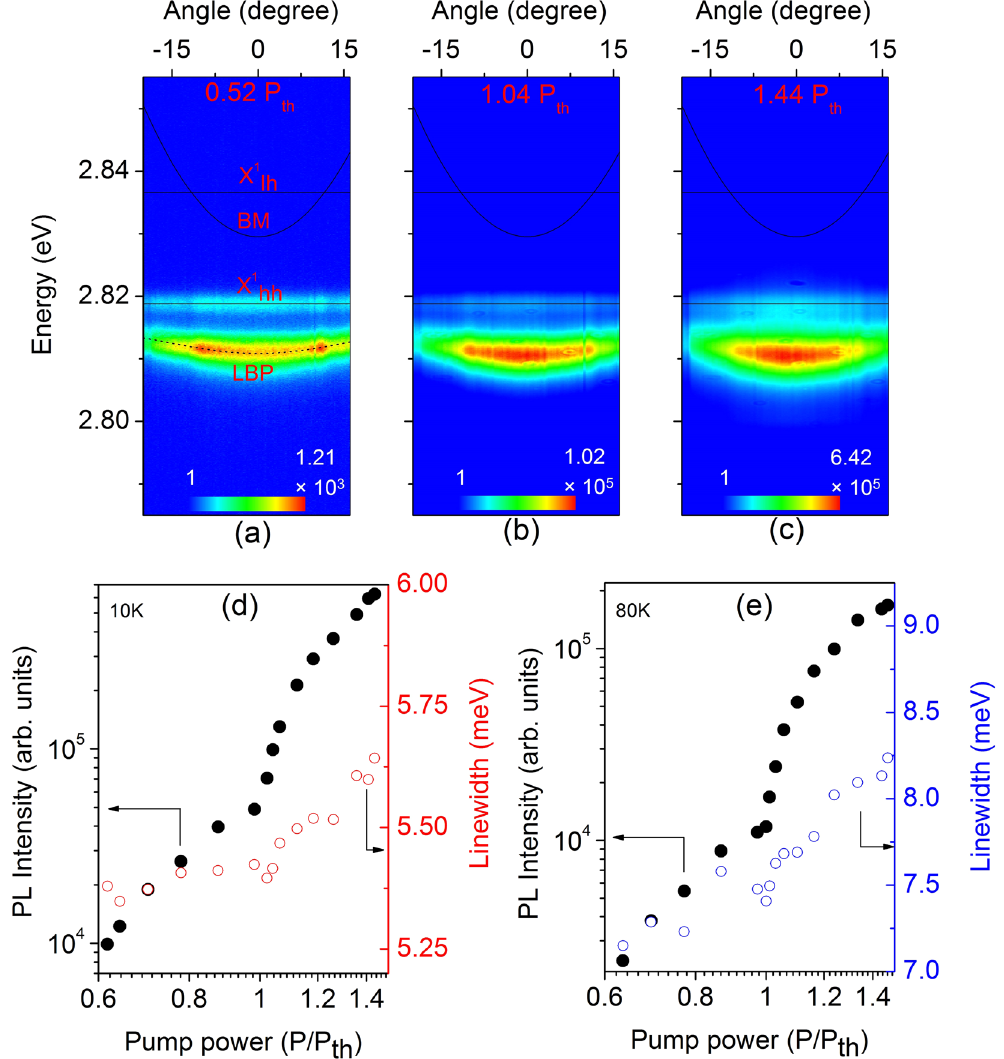
Figure 6. ( a – c ) The angular-resolved PL spectra of the hybrid Ag-Bragg structure for three different excitation powers at T = 10 K, the calculated bare BM (solid line) and LBP (dotted line) dispersion are displayed as well. The PL intensity and linewidth of the LBP mode ( θ = 0°) as a function of the excitation density for T = 10 K ( d ) and T = 80 K ( e ) are